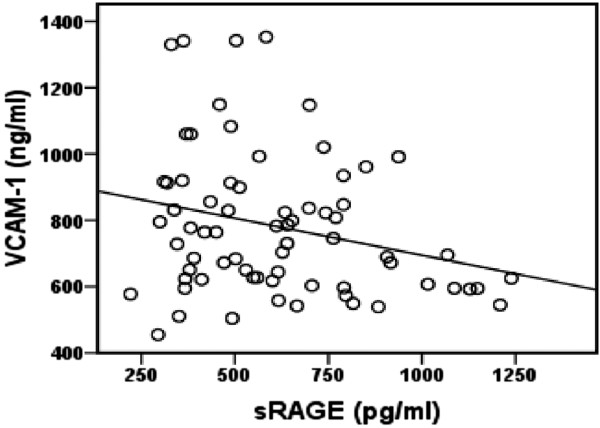
Correlation between sRAGE and VCAM-1 levels in T2DM patients (r = − 0.256, p = 0.032, n =70).